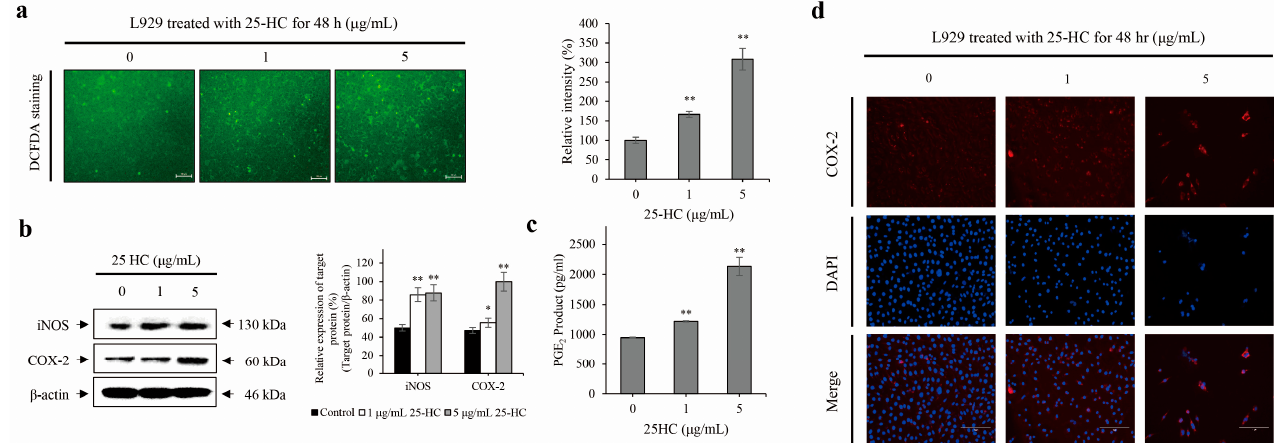
Figure 6. 25-HC upregulated the expression and production of ROS and inflammatory mediators in L929 cells. L929 cells were treated with 1 and 5 μ g/mL 25-HC for 48 h. Thereafter, DCFDA staining and intensity ( a ), Western blot ( b ) for iNOS and COX-2, PGE 2 ( c ) assay, and immunocytochemistry using COX-2 antibody ( d ) were performed to investigate the up- regulation of ROS and inflammatory mediators in L929 cells treated with 25-HC. ( a ) 25-HC increased the production of ROS in L929 cells. ( b – d ) The expression and production of inflammatory mediators including iNOS, COX-2, and PGE 2 were upregulated in L929 cells treated with 25-HC. The results of Western blot were expressed as the relative ratio of target protein/ β -actin. β -actin was used as the internal control. Significance was represented as * p < 0.05, ** p <